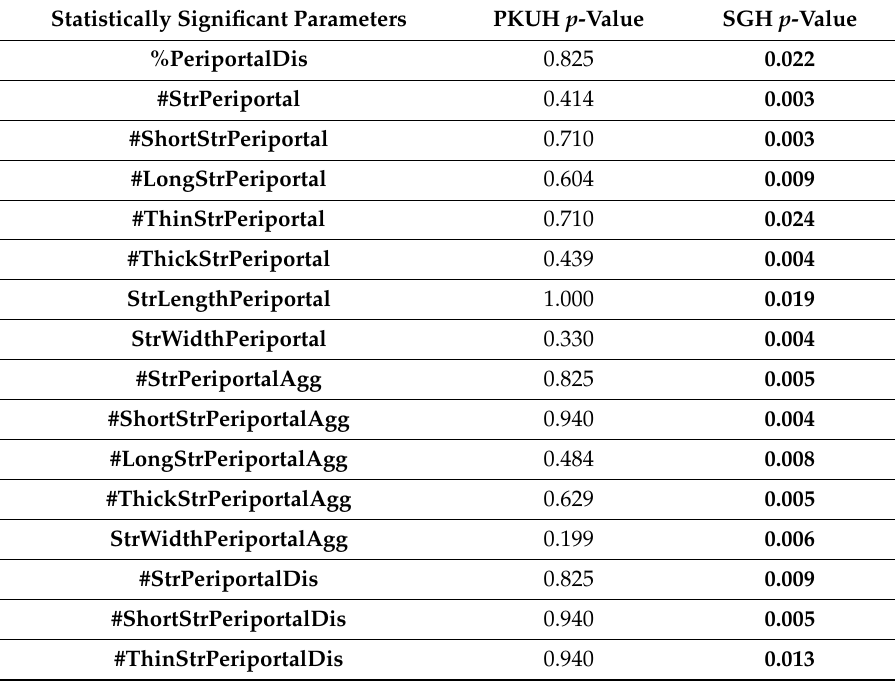
Table 5. List of 28 significantly di ff erent parameters in the SGH